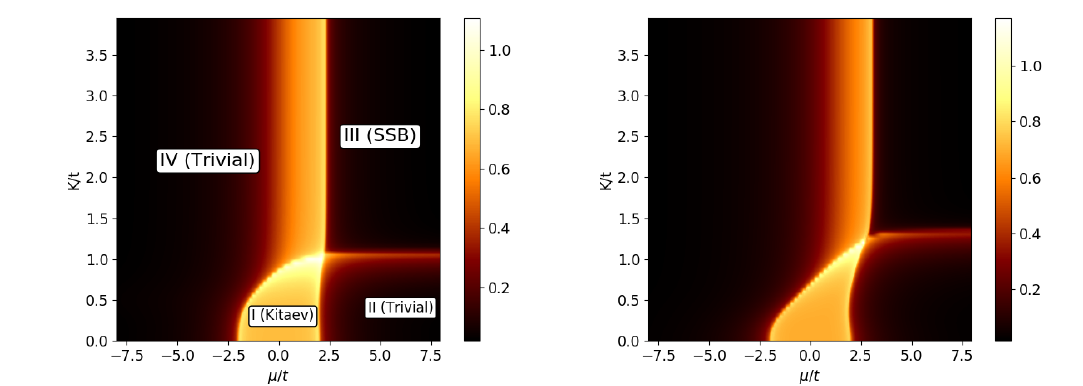
Figure 5: Half-chain entanglement entropy for a system described by the Hamiltonian (35) with h / t = 1 (left) and h / t = 2 (right). Results are obtained using DMRG for a chain of length L = 100. Phases are labeled as in section 4.1, except that the phase IV is not SPT anymore, but becomes trivial here. (For h / t = 0, see Fig. 4; for h / t = 5, see Fig.